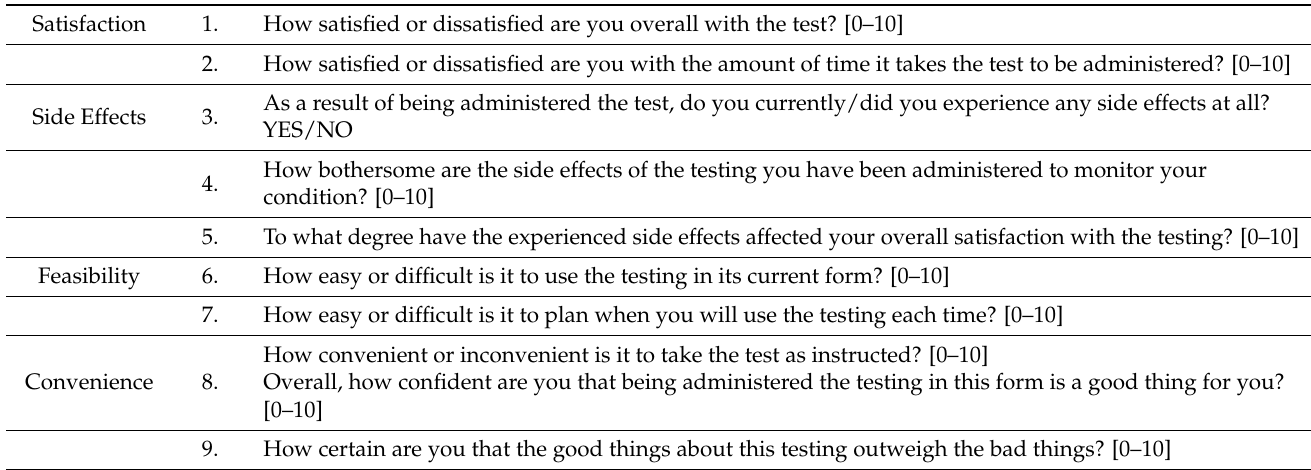
Table 2. Prevalence of autoantibodies in the patient